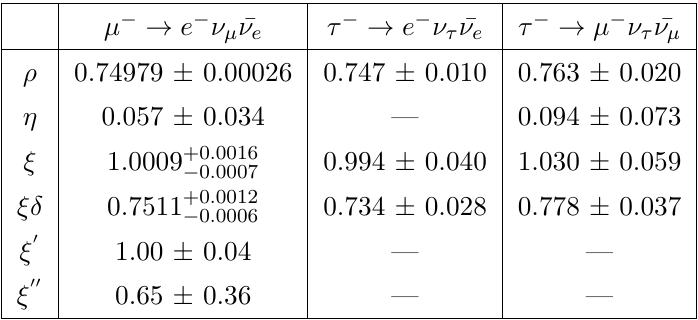
Table 1. Michel parameters and their most accurate